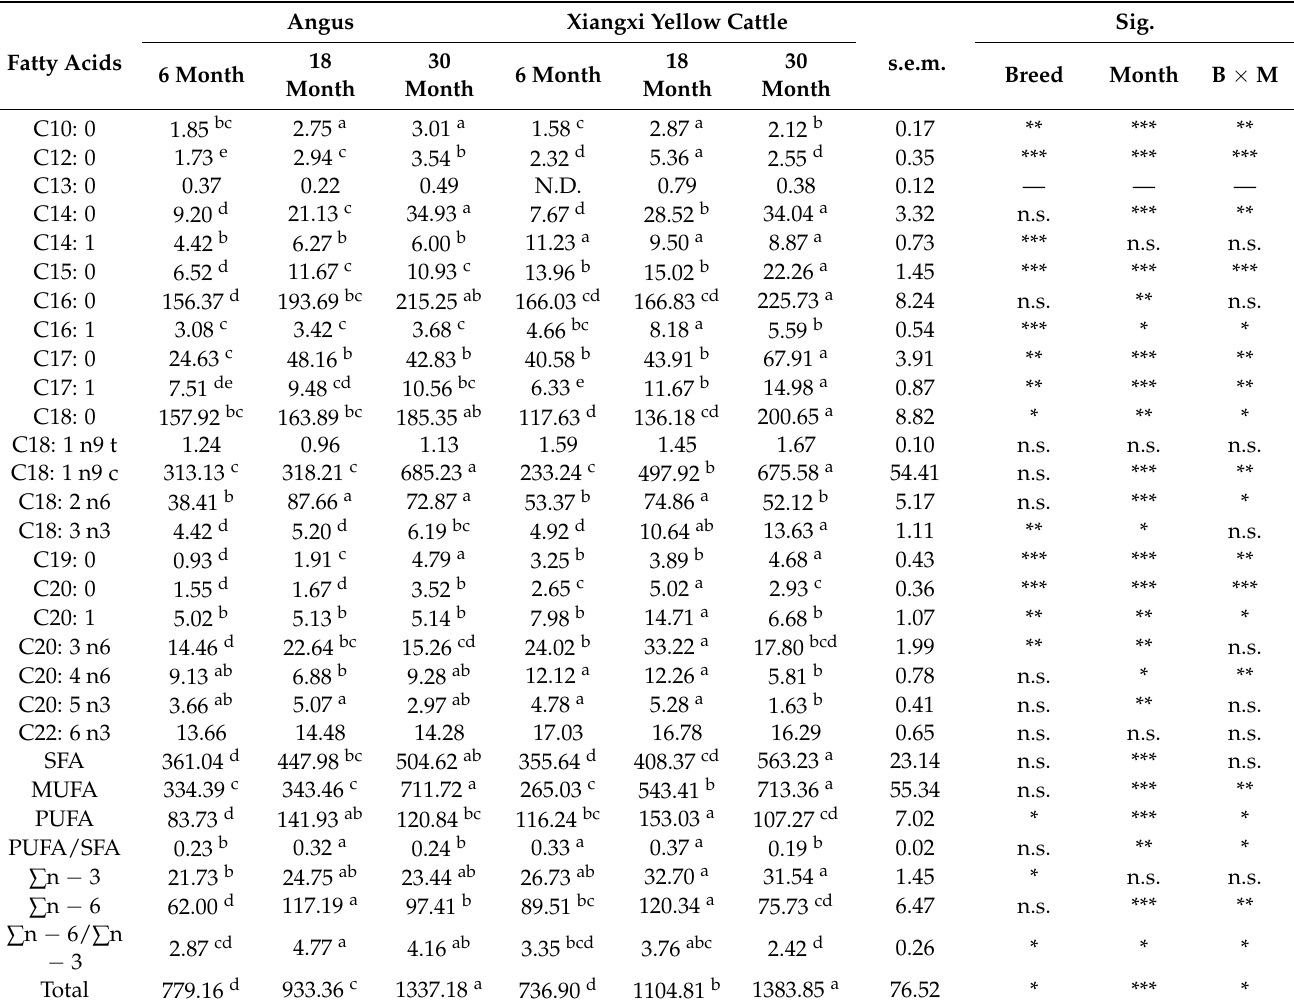
Table 3. Fatty acid concentrations (mg/100 g muscle) in the total lipid fraction of intramuscular fat of LT muscle from Angus and Xiangxi yellow